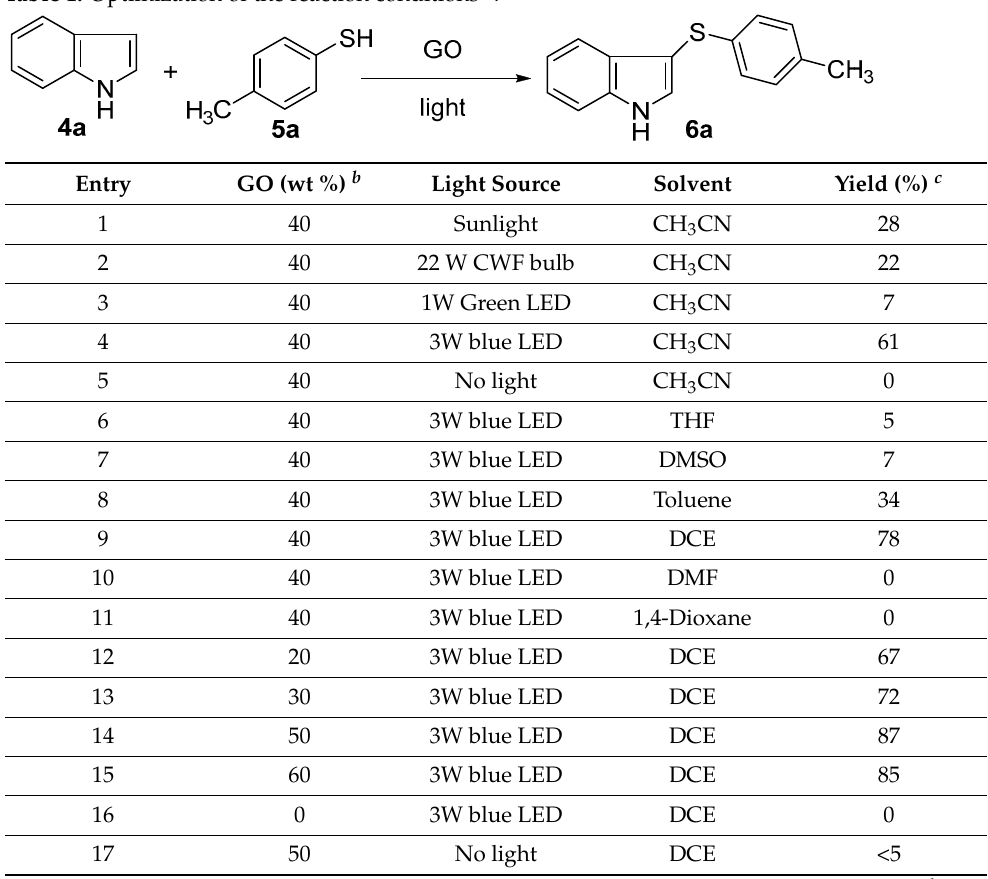
Table 1. Optimization of the reaction conditions a .